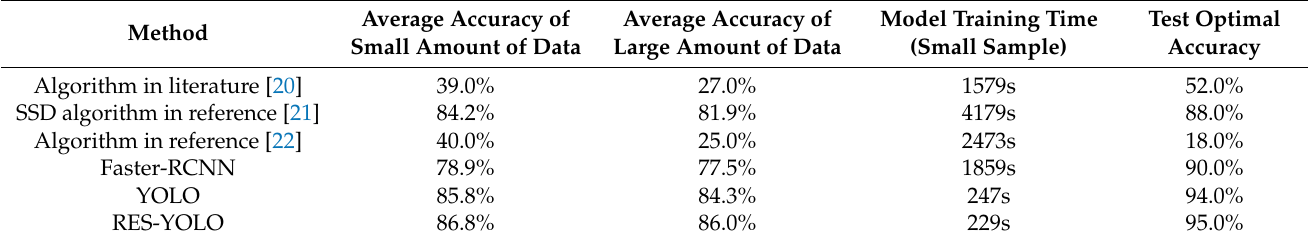
Table 4. Evaluation of multiple methods.